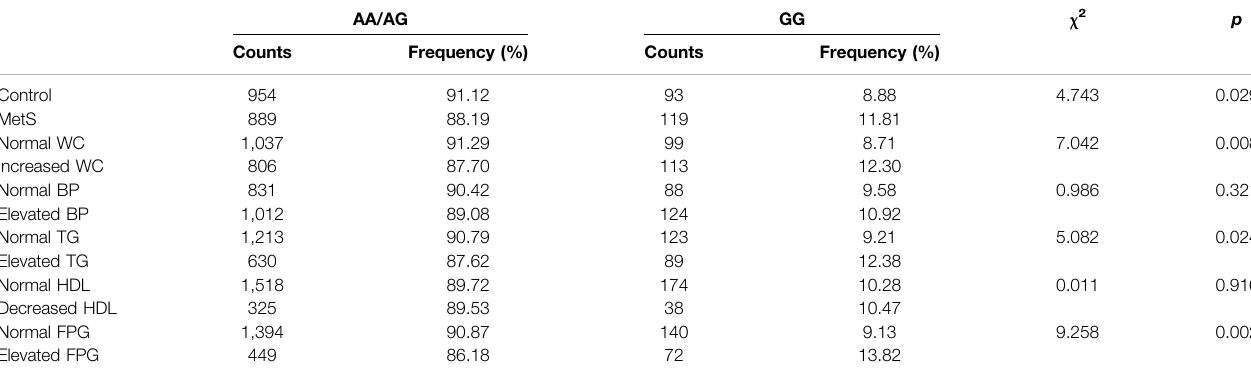
TABLE 2 | Distribution of M55V genotypes under a recessive model.